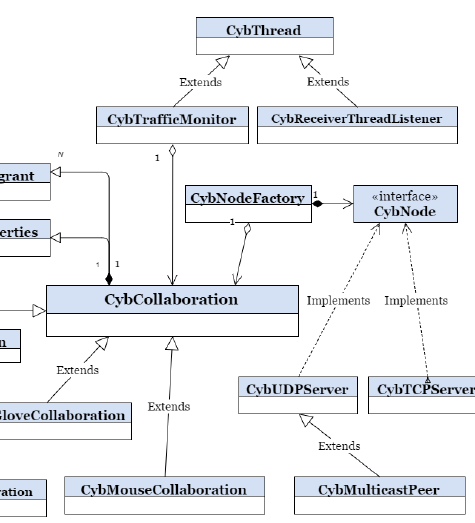
Fig. 3: The CybNodeFactory interaction with other networking classes.